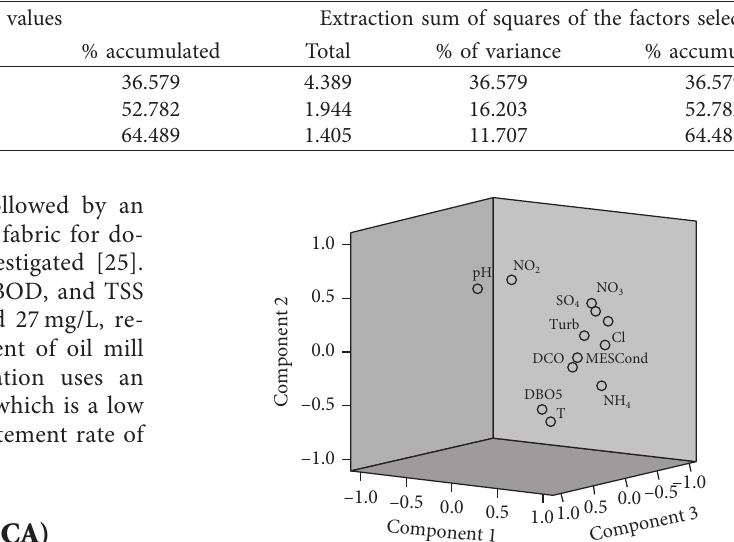
Table 6: Total variance explained.